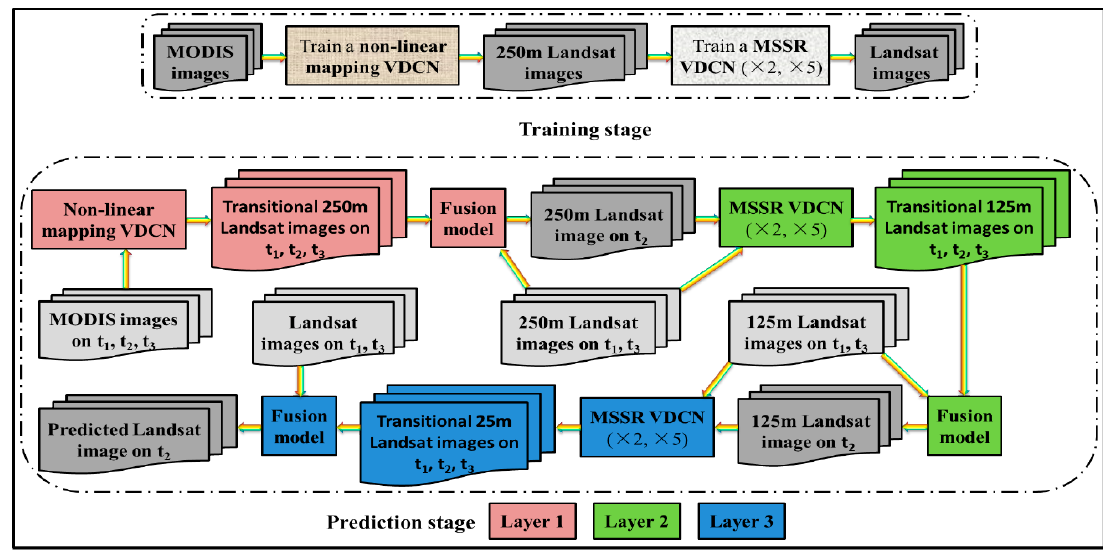
Figure 1. Flowchart of our method.